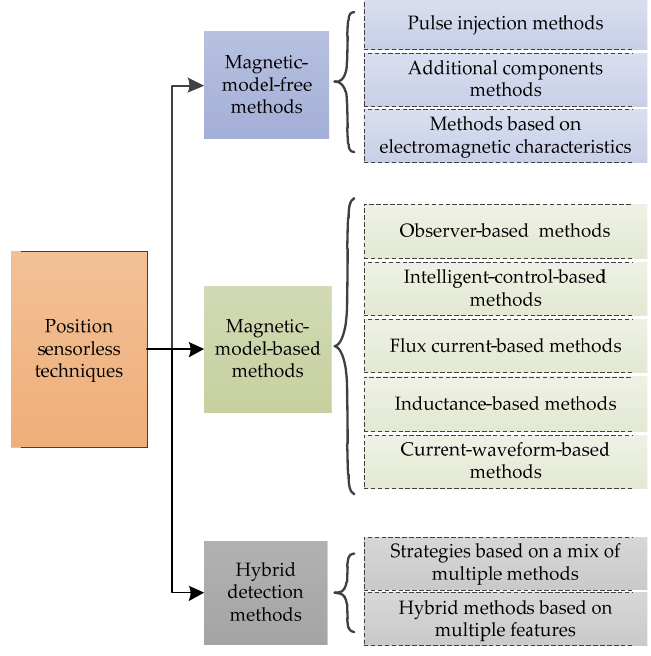
Figure 2. Classification of control methods of position sensorless.